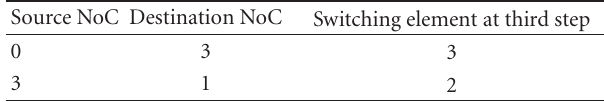
Table 19: Initial data used to set up communication between NoCs. Source